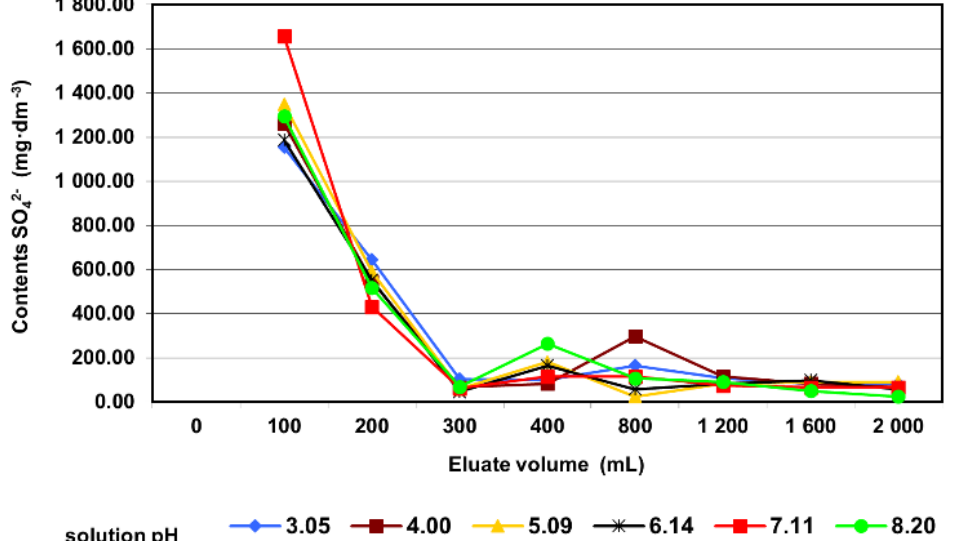
Figure 9. Contents of SO 42− ions in successive portions of the collected eluate depending on the pH of the initial leaching solution.